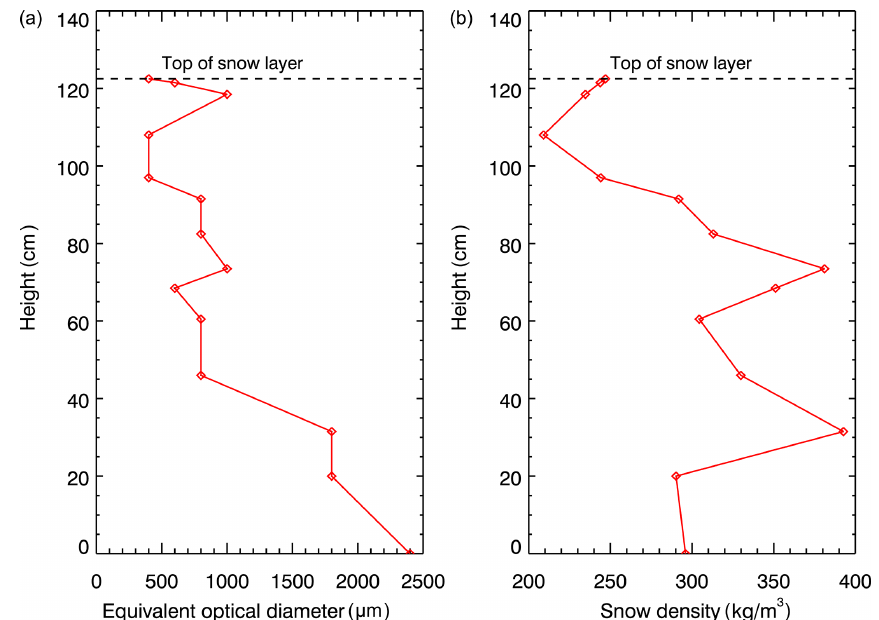
Figure 14. Snow properties used for simulations to investigate the impacts of snow layer model on the XBAER retrieval (a) snow grain size profile and (b) snow density observed during the SnowEx17